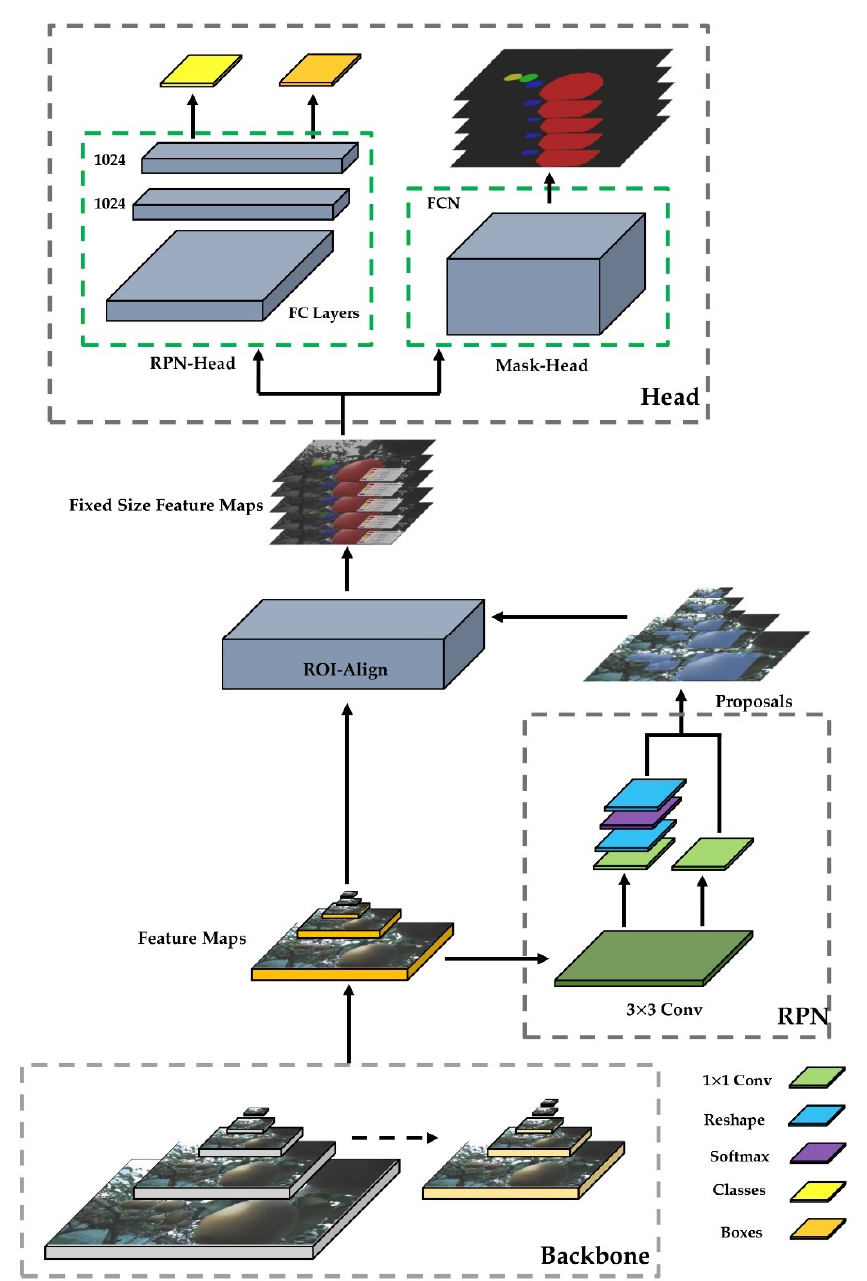
Figure 3. Mask R-CNN structure for pear quantity in orchards from 3D camera datasets. The origi- nal images enter the backbone network for selection and screening to get the feature maps. Then, the foreground and background are extracted in the RPN network, enter the ROI-Align network for standardization, and finally enter the head network to generate classes, boxes, and masks for pear